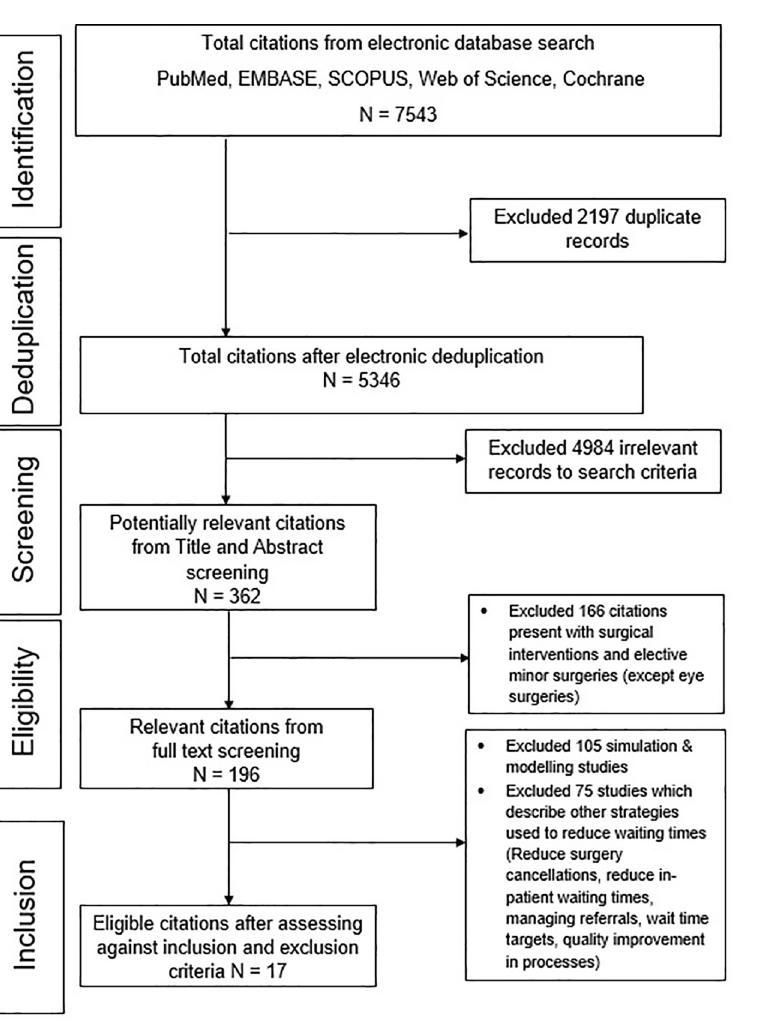
Fig 1. PRISMA flow diagram for eligible article selection for the systematic